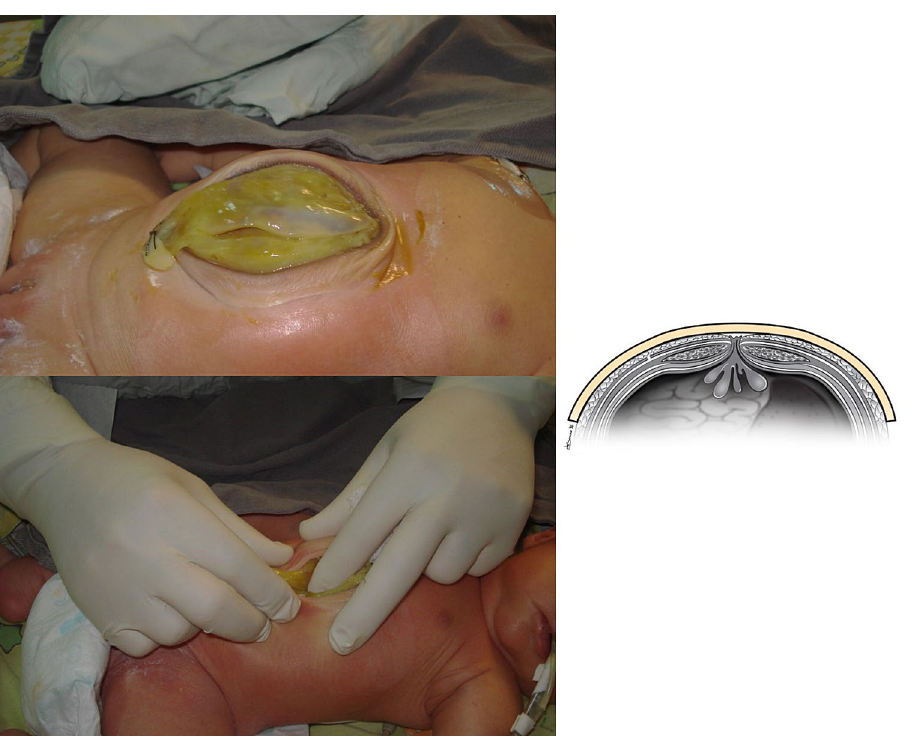
Figure 2. Phase 2 or skin closure with gradual amnion